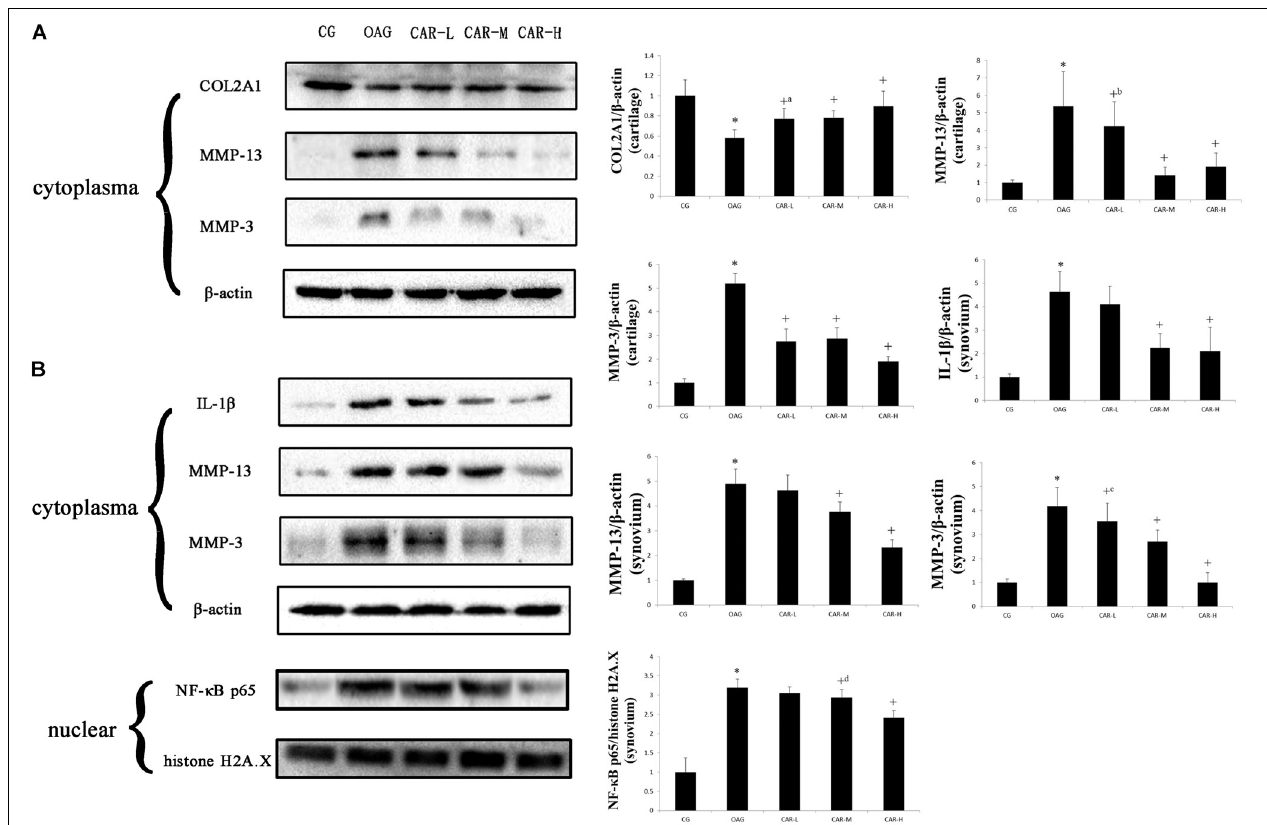
FIGURE 5 | Western blotting results. Protein expression was determined in western blots of total protein extracted from cartilage (A) and synovium (B) . The data were obtained from three separate experiments β -actin or histone H2A.X was the internal standard. Differences between the CG and OAG group were significant ( ∗ P < 0.001), and differences between the OAG and the different doses of CAR were significant ( + P < 0.001, + a P = 0.001, + b P = 0.014, + c P = 0.008, and + d P = 0.010). One-way ANOVA, n = 3 rats for each group; means with 95% confidence